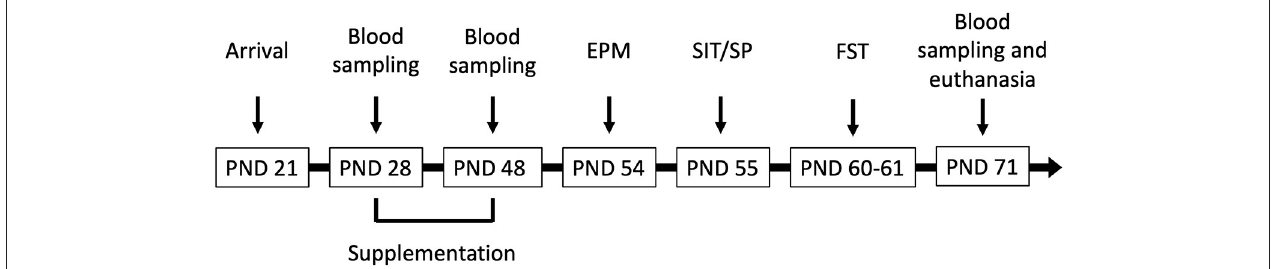
FIGURE 1 | Male Wistar rats ( N = 41) arrived at the facility on postnatal day (PND) 21 and were supplemented corn oil ( n = 10; control), bisphenol A (BPA; 40 mg/kg; n = 10), hop extracts (40 mg/kg; n = 11), or a BPA-Hop mix ( n = 10) from PND 28–48. Afterwards, rats were tested in the elevated plus maze (EPM), the social interaction/preference tests (SIT/SP), and the forced swim test on PND 54, 55, and 60–61, respectively. Blood samples were taken on PND 28, 48, and 71. Rats were euthanized on PND 71 following the last blood collection.